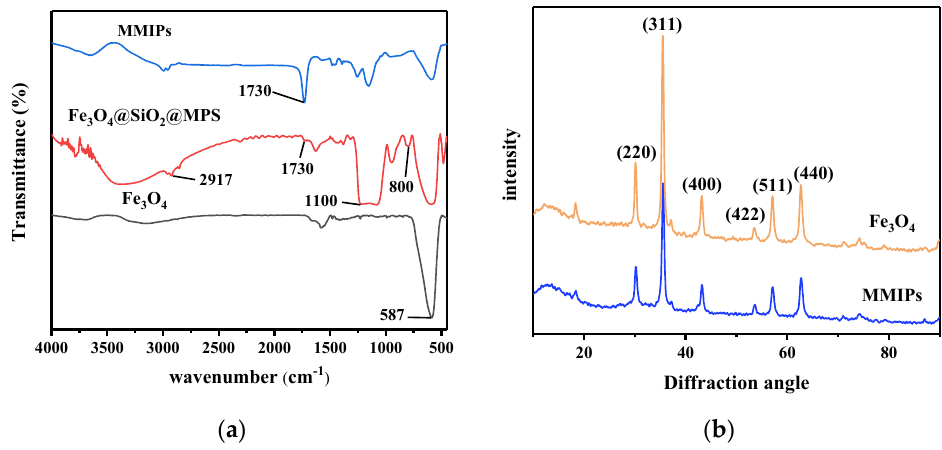
Figure 3. ( a ) FTIR spectra of Fe 3 O 4 , Fe 3 O 4 @SiO 2 @MPS, and MMIPs; ( b ) XRD patterns of Fe 3 O 4 and MMIPs.